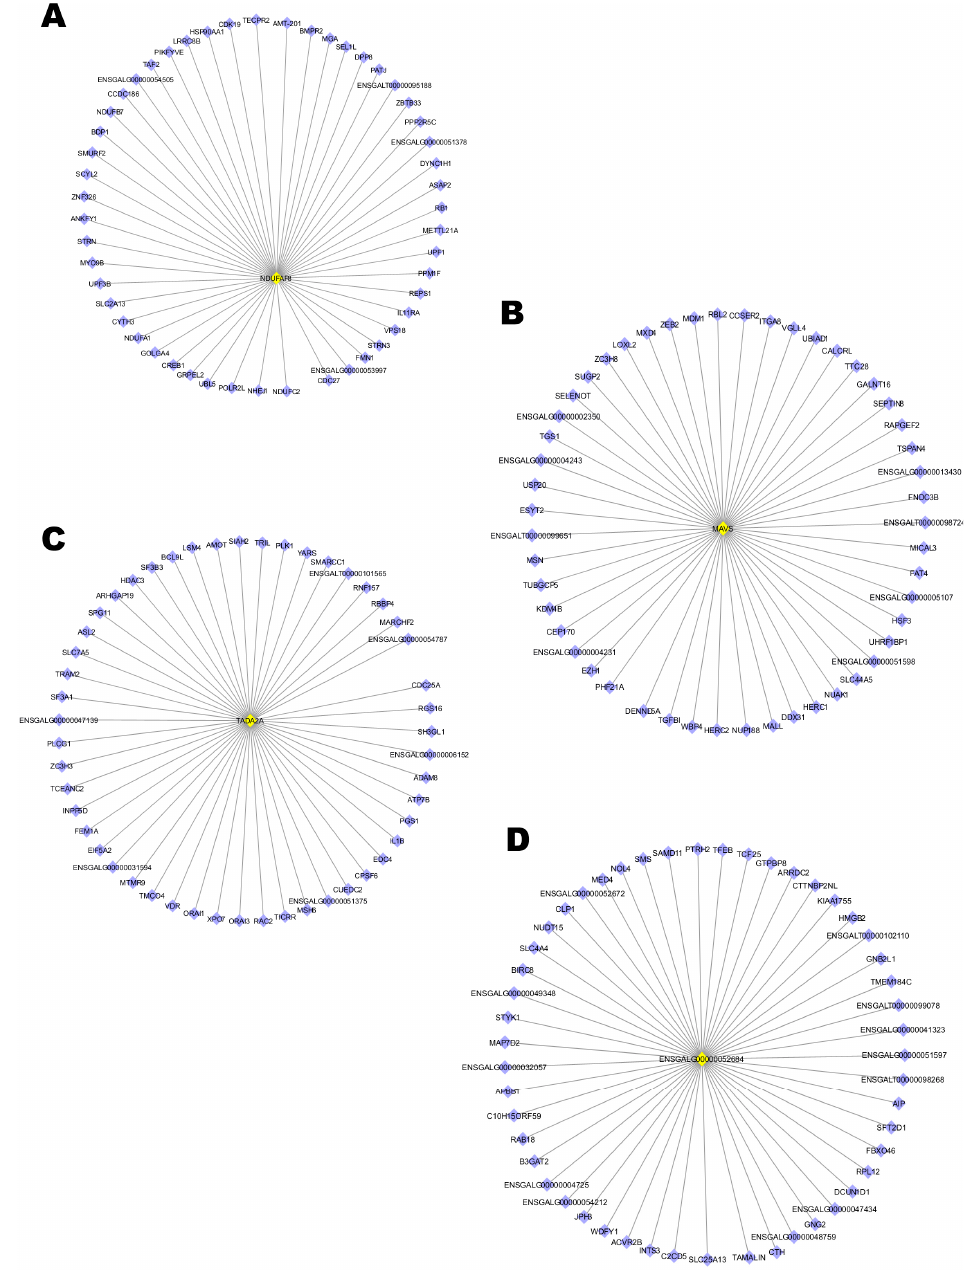
Figure 6. Co-expression network of hub genes. ( A ) Hub genes of the blue module. ( B ) Hub genes of the brown module. ( C ) Hub genes of the green module. ( D ) Hub genes of the yellow module. To assess the biological process regulated by the hub genes and their effect on the resistance to Salmonella infection, GO enrichment and KEGG pathways analyses were performed for the genes detected in the blue, brown, green, and yellow modules (Figure 7). The KEGG analysis showed that the oxidative phosphorylation metabolic pathway was significantly enriched by the cluster of genes from the blue module. It was noteworthy that among the four modules selected, the green module showed more enriched GO terms and KEGG pathways related to the immunity than the blue, brown, and yellow modules (Figure 7). Among the top 20 GO terms significantly enriched in the green module, inflammatory response, lymphocyte activation, regulation of immune system, T cell activation, immune response, leukocyte activation, positive regulation of